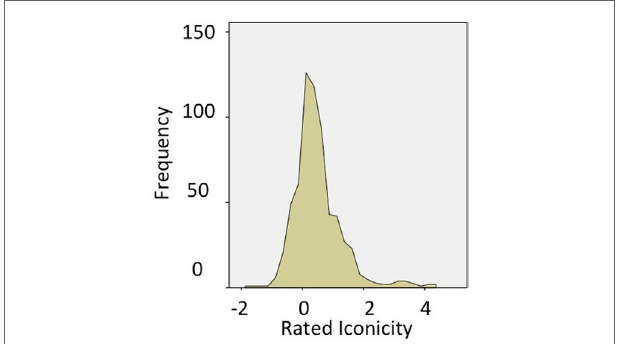
FigUre 2 | The frequency of occurrence per 1 million words across age for the 4 groups of 26 words with high, some, neutral, and opposite iconicity . Age represents the 3-month intervals beginning with the age indicated on the abscissa. The production results taken from ChildFreq (Baath, 2014).